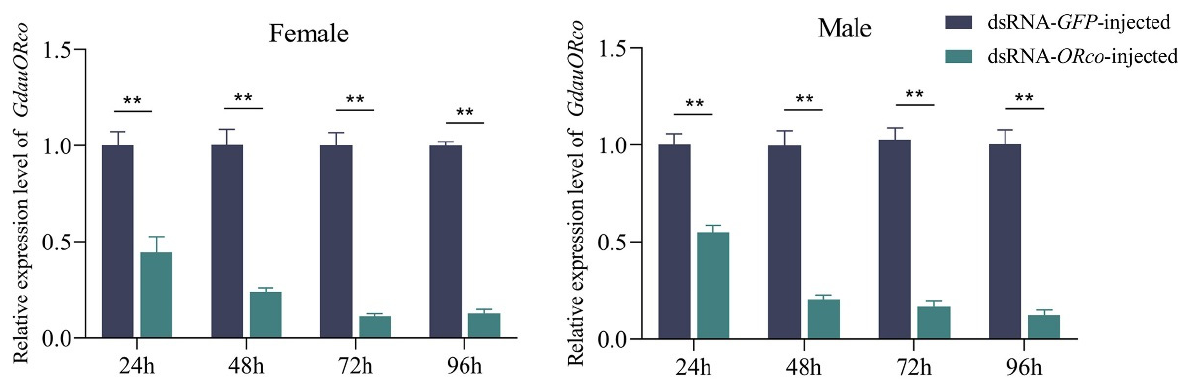
Figure 3. Expression level of GdauORco after RNAi. The relative expression levels of GdauORco in antennae of dsRNA-injected female and male at different times ( T -test; **: p < 0.01).